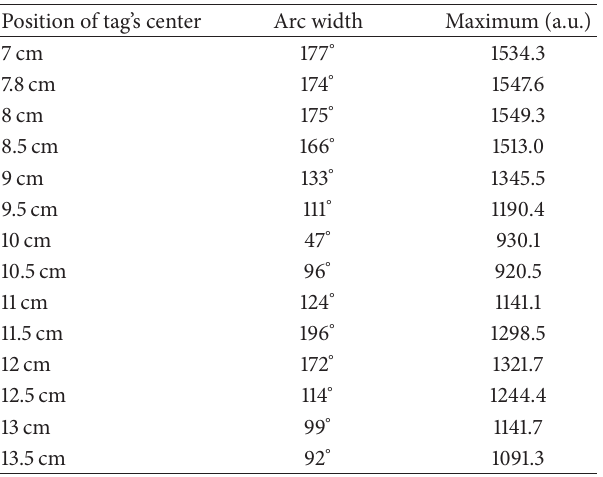
Table 6: Maximum received signal and reading arc values at different tag